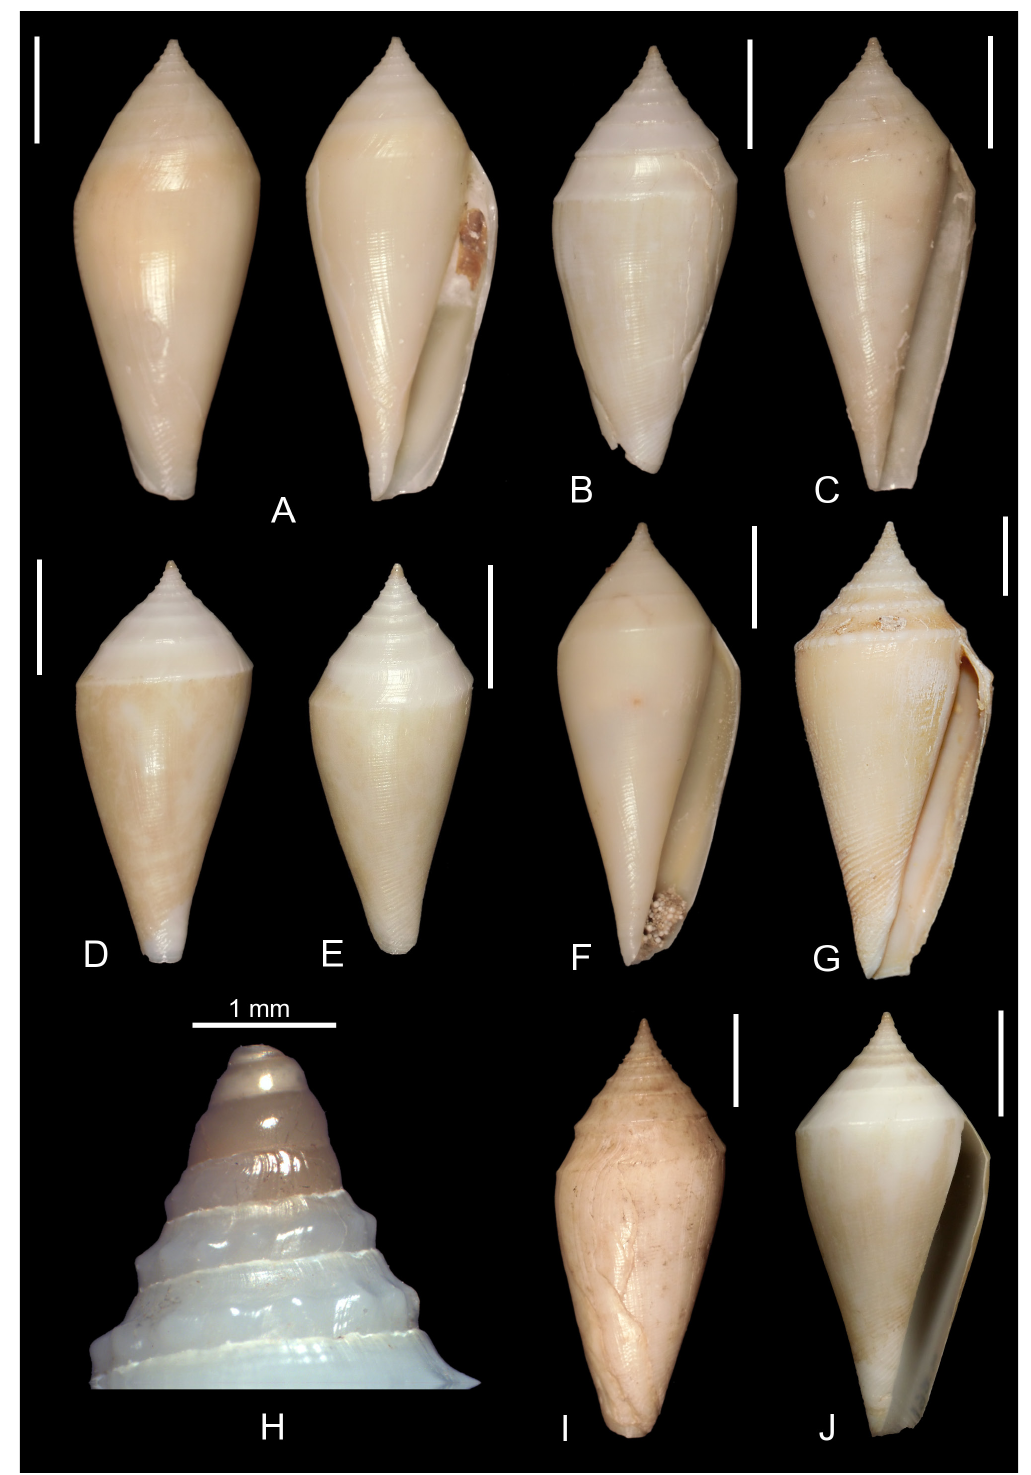
Fig. 12. Profundiconus puillandrei sp. nov. A . Holotype, 43.2 × 18.0 mm. B . Paratype 1, 39.6 × 17.3 mm. C . Paratype 2, 40.7 × 16.8 mm. D . Paratype 3, 35.0 × 15.5 mm. E . Paratype 4, 43.6 × 18.1 mm. F . Paratype 5, 43.6 × 18.1 mm. G . Paratype 6, 57.3 × 24.6 mm. H . Paratype 4, enlargement of the spire. I . Paratype 7, 45.2 × 18.5 mm. J . Paratype 8, 38.9 × 17.5 mm. Scale bars = 10 mm unless otherwise